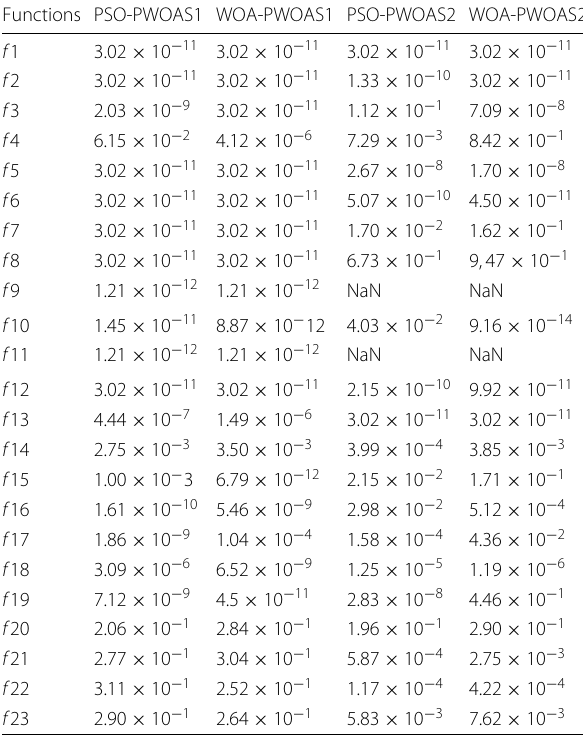
Table 3 The non-parametric statistical hypothesis test results of simulation